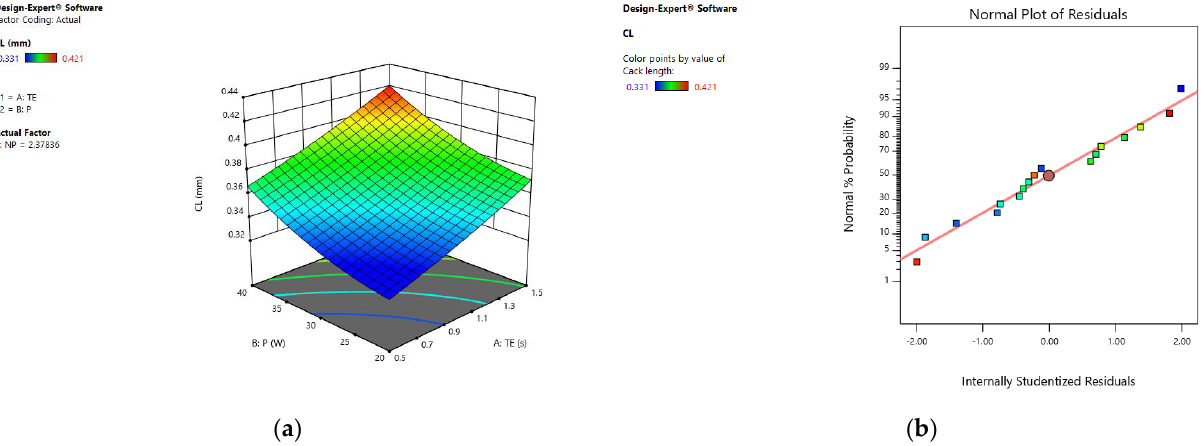
Figure 14. ANOVA model results for CL at 0.075 wt.% CNPs: ( a ) 3D response surface and ( b ) normal residuals plot.